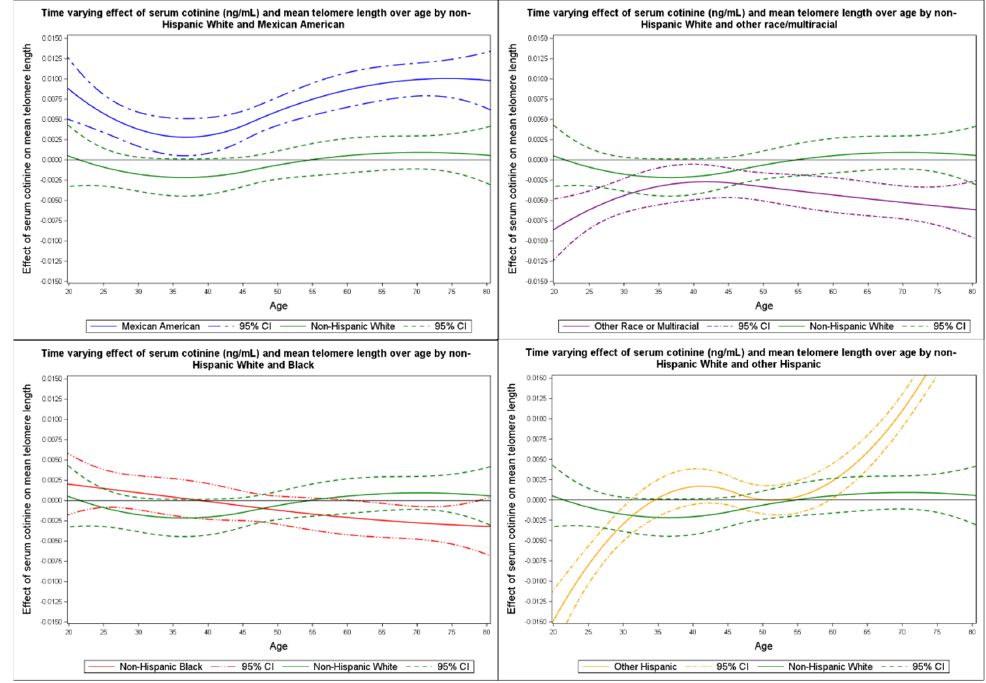
Figure 4. Time varying effect of serum cotinine on mean telomere length by race compared to non-Hispanic Whites.